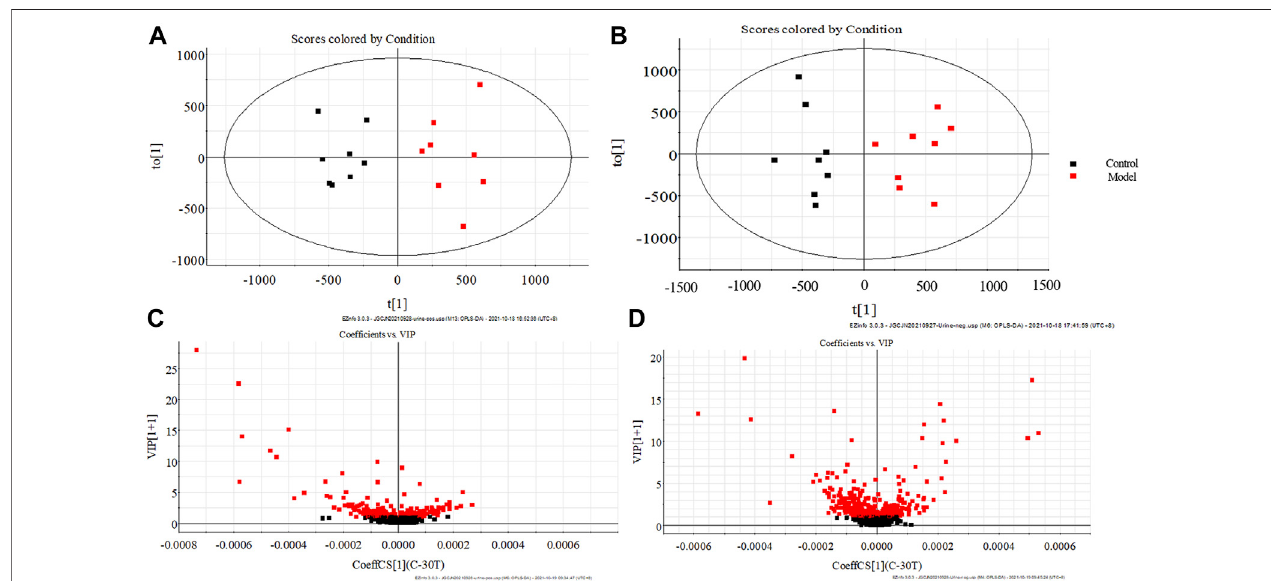
FIGURE 5 | OPLS-DA score plots of rat urine in control group and model group (A) positive ion pattern; (B) negative ion pattern. VIP scatter plots of rat urine in control group and model group. (C) positive ion pattern; (D) negative ion pattern.